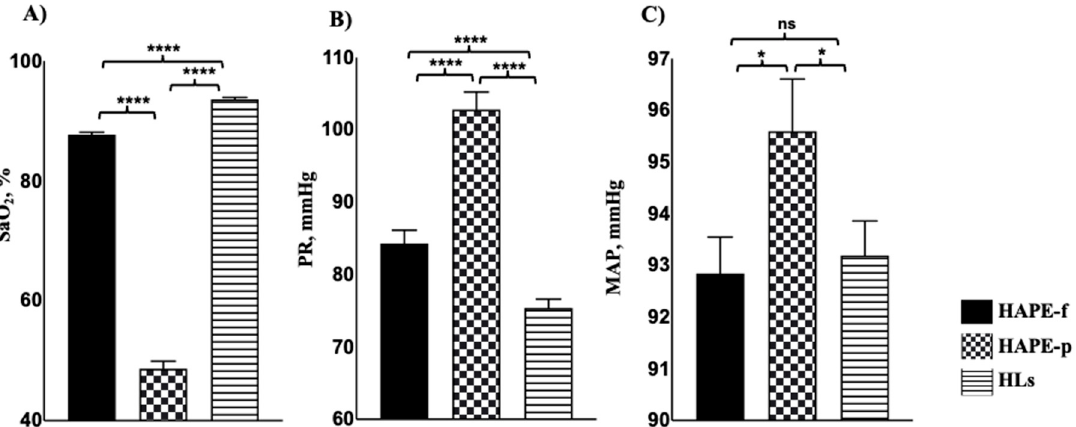
Figure 1. Clinical characteristics of the three study groups. Among the clinical parameters, ( A ) SaO 2 levels were lower in the HAPE-p ( n = 310) compared to the HAPE-f ( n = 310) and HLs ( n = 310) ( p < 0.001); ( B ) PR was elevated in HAPE-p compared to HAPE-f and HLs ( p < 0.001), and ( C ) MAP was also elevated in HAPE-p compared to HAPE-f and HLs ( p < 0.05). Data are presented as mean ± SE and are compared by a two-tailed t -test. * p < 0.05, **** p < 0.0001 was considered statistically significant. ns, non-significant; SE, Standard error.